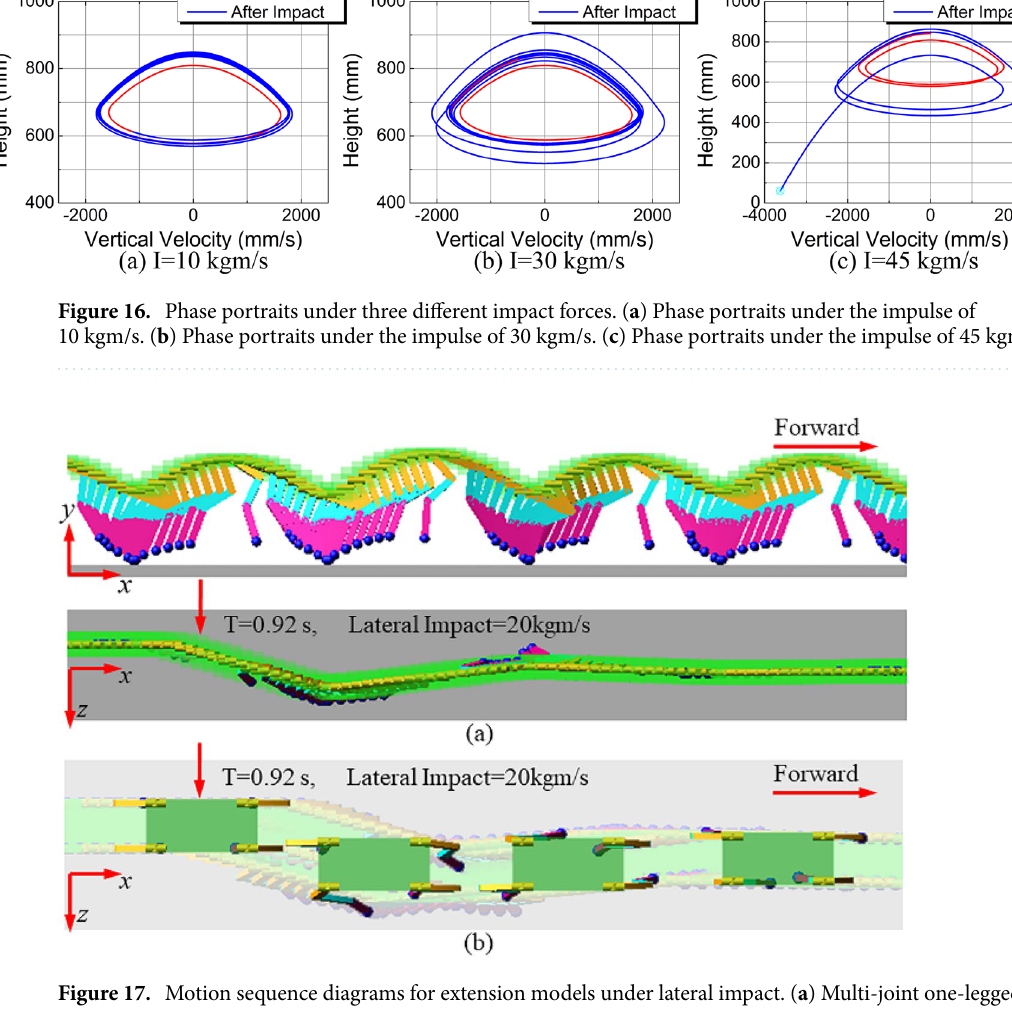
Figure 17. Motion sequence diagrams for extension models under lateral impact. ( a ) Multi-joint one-legged model, ( b ) Four-legged